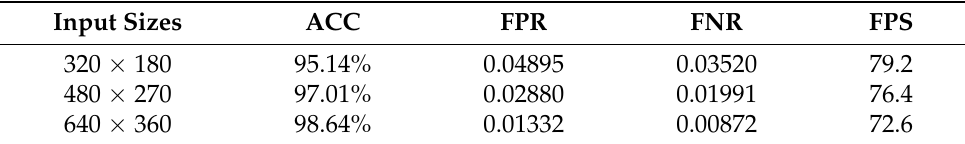
Table 6. The results of different picture sizes on